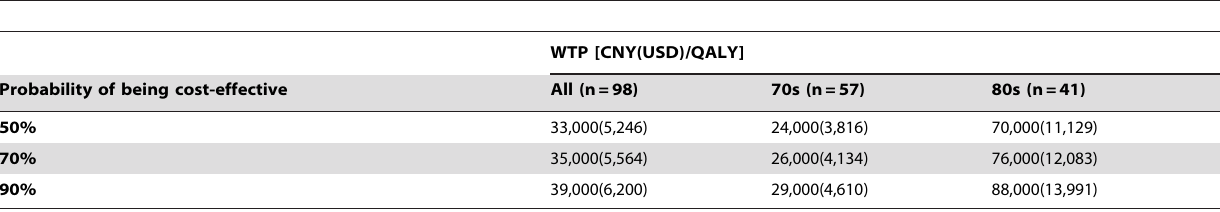
Table 4. Threshold ratios of WTP (CNY (USD)/QALY) for RRD surgery to be cost-effective at probabilities of 50%, 70% and 90% compared with no treatment option.